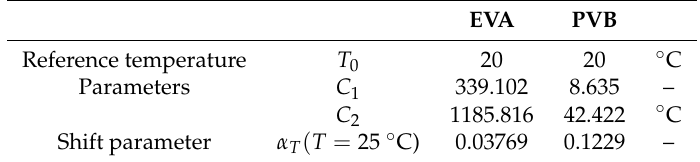
Table 7. Parameters for the time-temperature superposition using the William–Landel–Ferry equation [65].